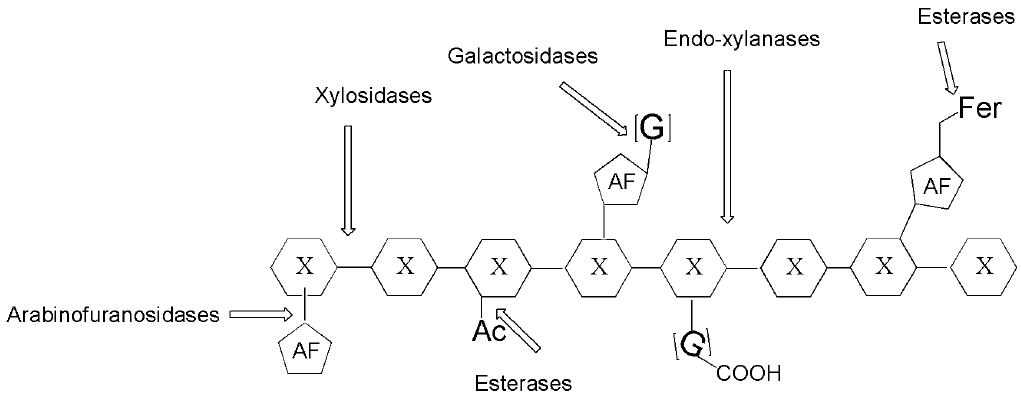
Figure 2. Schematic representation of enzymes attacking xylan chains. Arabinofuranosidase as one of the enzyme for the complete hydrolysis of xylan. X in the hexagon is the symbol used for xylose; AF in the pentagon is for arabinofuranose; G is galactose; Ac is the acetyl group; G-COOH is glucuronic acid.